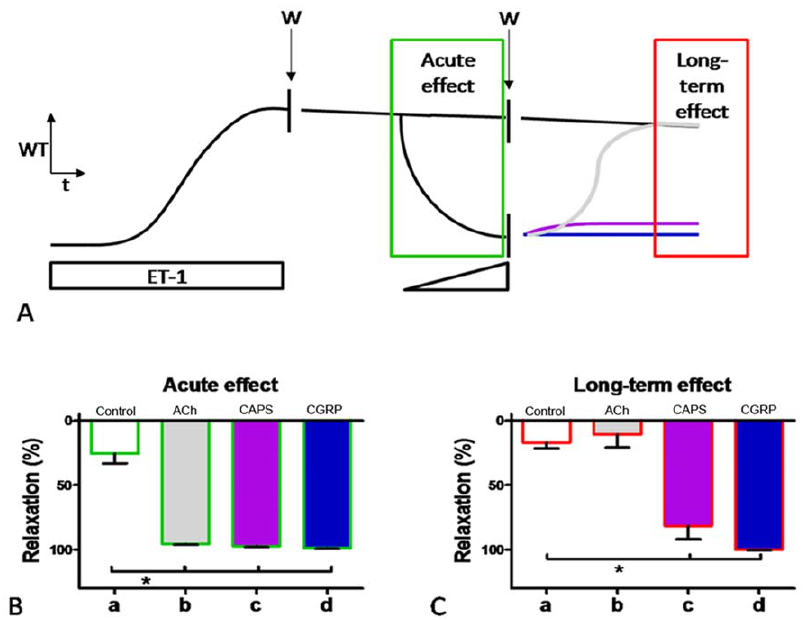
Figure 3. Capsaicin, CGRP and acetylcholine relax endothelinergic arterial contraction that remained after removal of ET-1 from its biophase but only capsaicin and CGRP prevent the persistent contractile effect of ET-1. A, schematic tracings of active wall tension (WT) versus time (t) illustrating i) ET-1-induced contractions that are not reversed upon agonist removal (W), ii) acute effects of various dilators and iii) prevention of long-term ET-1 effects by capsaicin (purple) and CGRP (blue) but not acetylcholine (grey). B, maximal acute relaxing effects of acetylcholine (b), capsaicin (c) or CGRP (d). C, long-term effects of acetylcholine (b), capsaicin (c) or CGRP (d). For concentrations of vasodilators see ‘‘Methods’’ section. n=6–8. *: P , 0.05 vs.